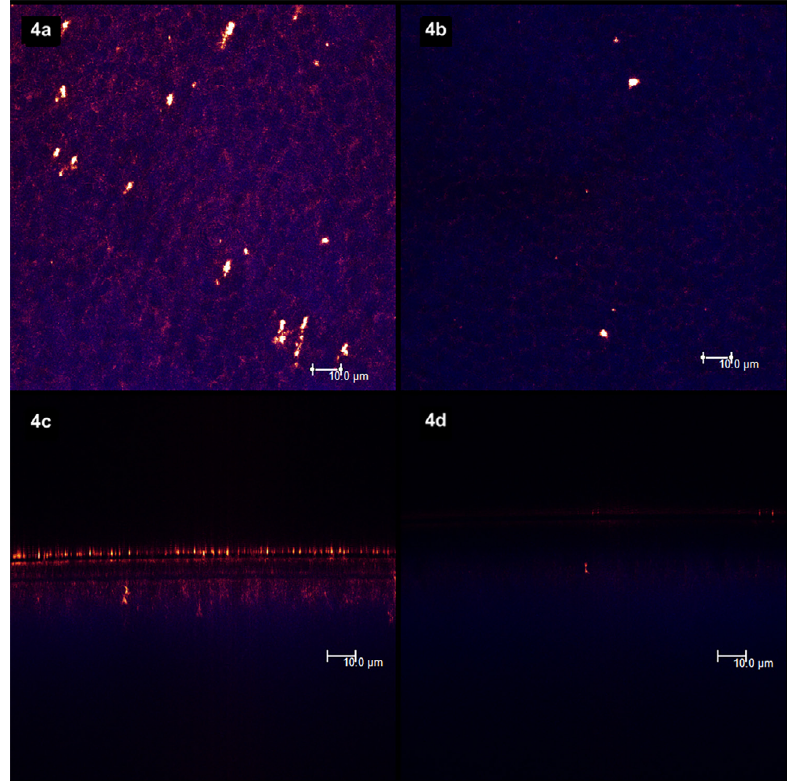
Figure 4- The toothpaste containing 1 wt.% of S-PRG fillers could not promote the formation of solid deposits on the surface (4a) and at the aperture (4c) of dentinal tubules. After the acid challenge, the surface (4b) and the aperture of the tubules (4d) were mostly free of deposits